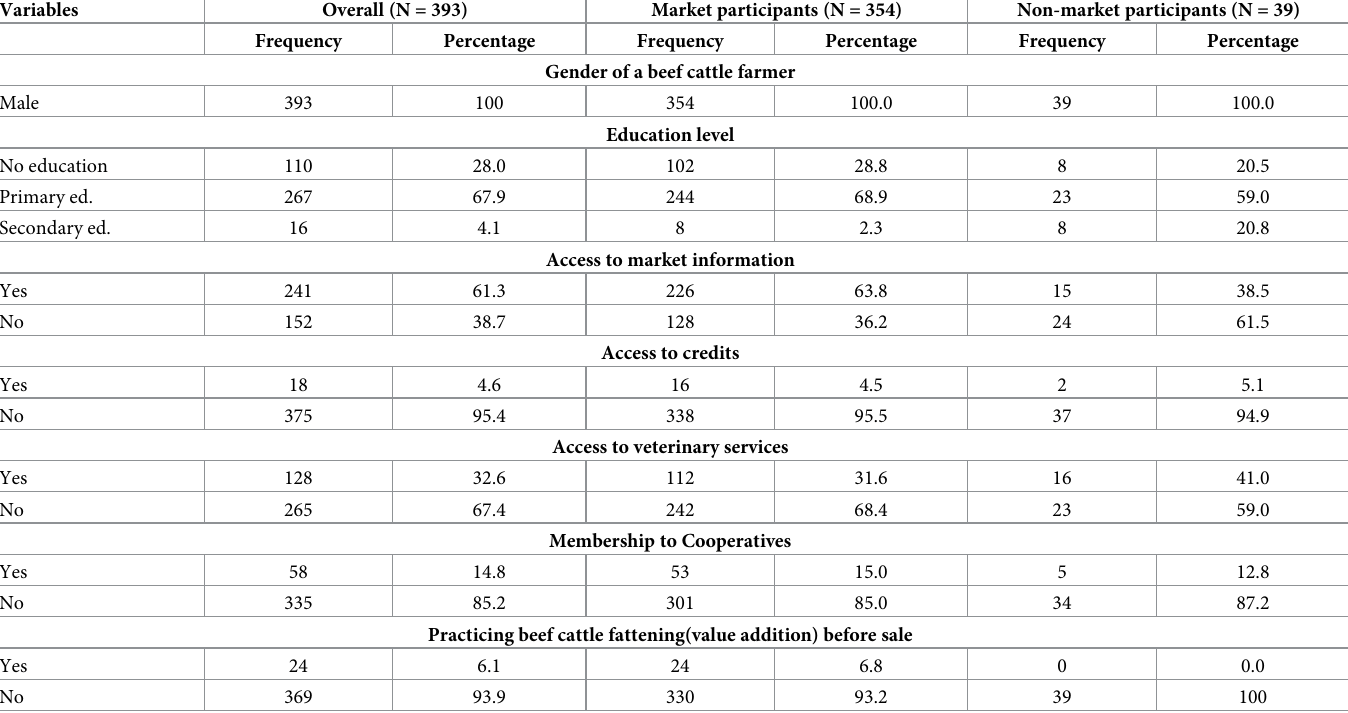
Table 4. Comparison of socioeconomic characteristics between market and non-market participants based on frequency and percentage scores of categorical variables.